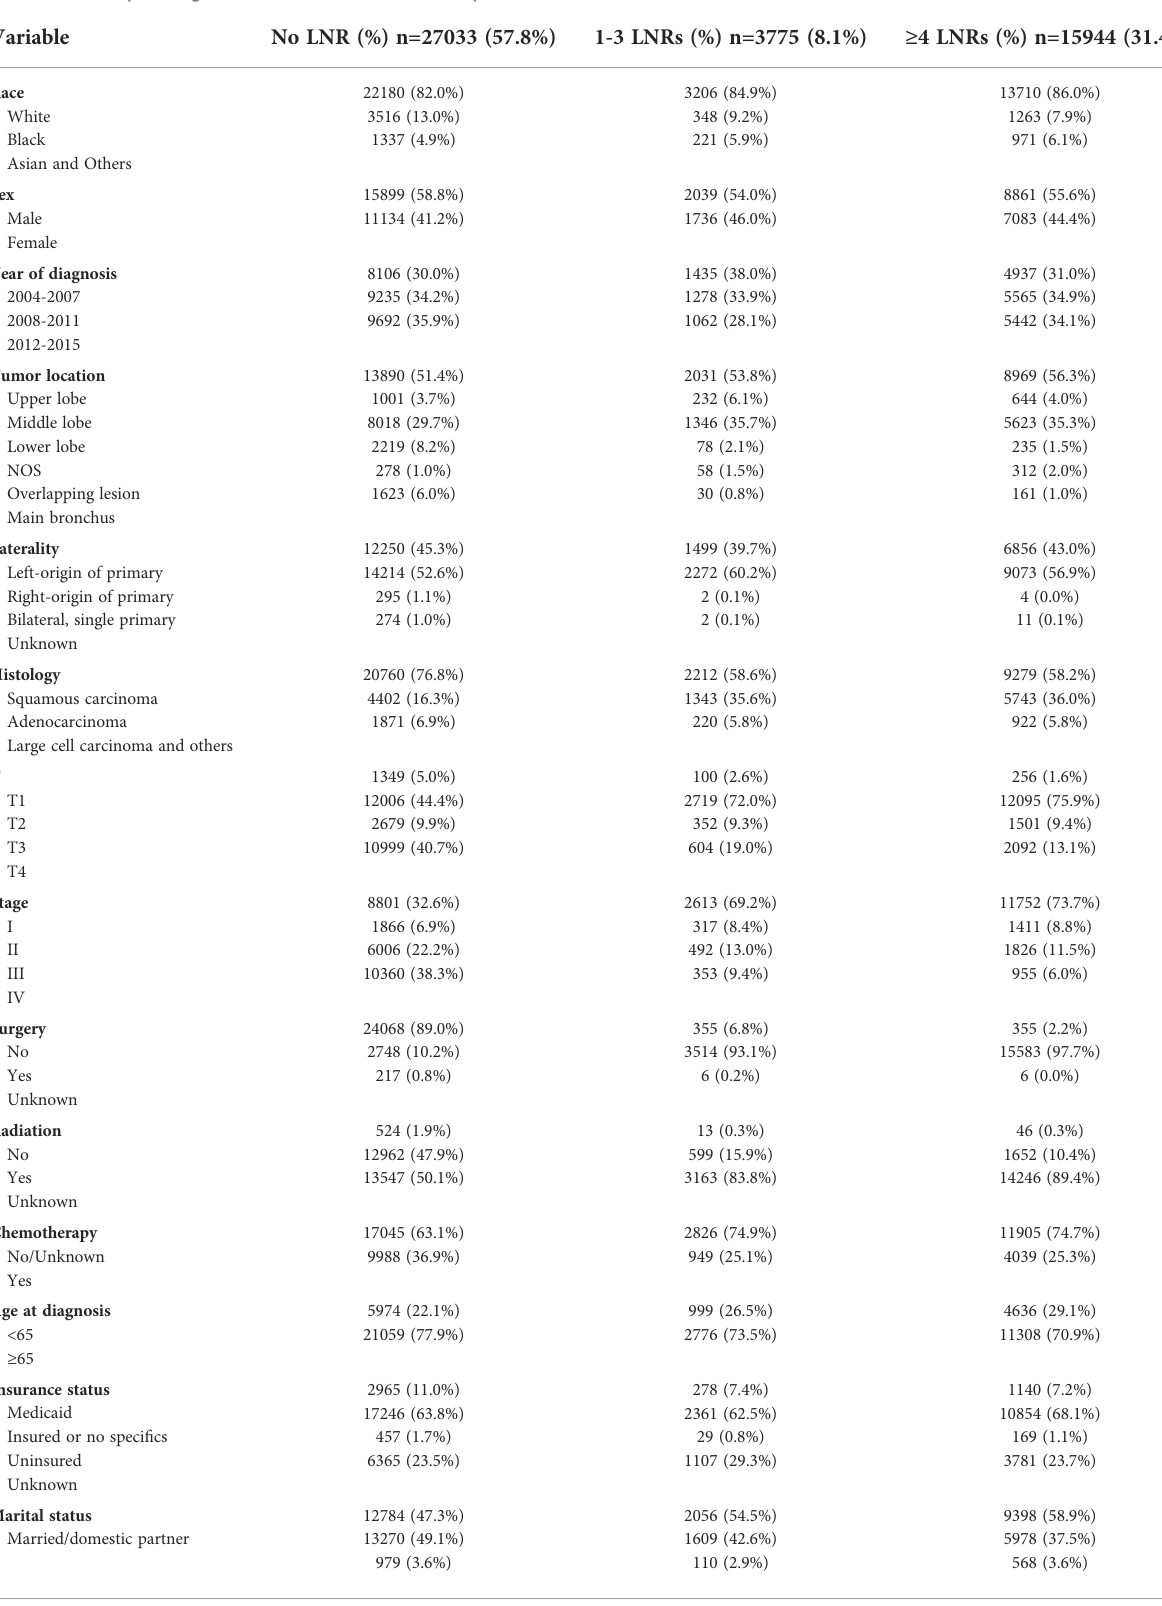
TABLE 1 Clinicopathological characteristics of N0 NSCLC